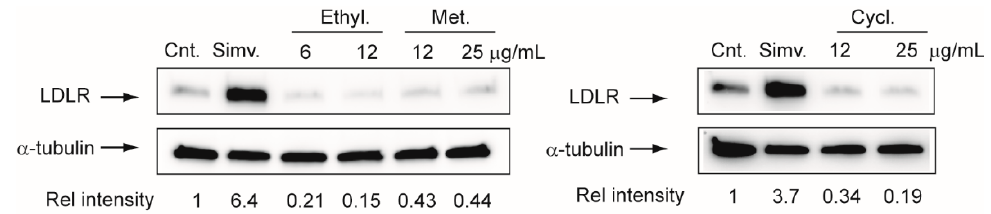
Figure 7. E ff ect of di ff erent solvent extracts of G. diversifolia on LDLR expression in Huh7 cell line. Human hepatoma cells Huh7 were incubated for 72 h with indicated concentrations of G. diversifolia extracts, and LDLR reductase protein expression was evaluated by western blot analysis. α -Tubulin was used as a loading control. Densitometric readings were evaluated using the ImageLab TM software and expressed as relative intensity (Rel. Intensity) compared with control. Cnt.: Control;